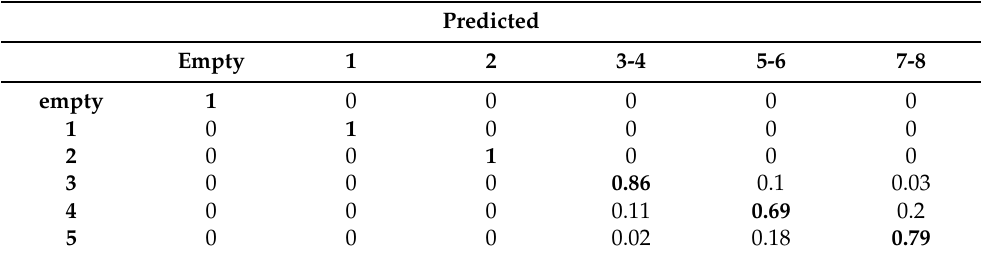
Table 4. Confusion matrix in room B with maximum 8 people and Decision Tree classifier.